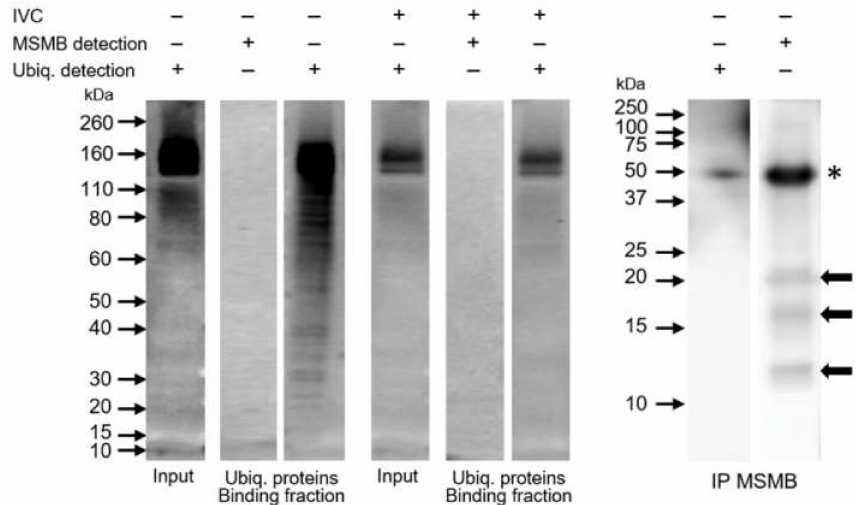
Figure 6. Immunodetection of porcine MSMB in (poly)ubiquitinated protein sample isolated from the extract of whole ejaculated and IVC spermatozoa using the Signal-Seeker TM Ubiquitination Detection kit (Ubiq. proteins—Binding fraction) with control detection of polyubiquitinated proteins and reciprocal detection of ubiquitinated proteins in MSMB immunoprecipitate (IP MSMB) from the extract of ejaculated spermatozoa with control detection of MSMB. Black arrows show MSMB (12, 17 and 22 kDa); asterisk indicates antibody heavy